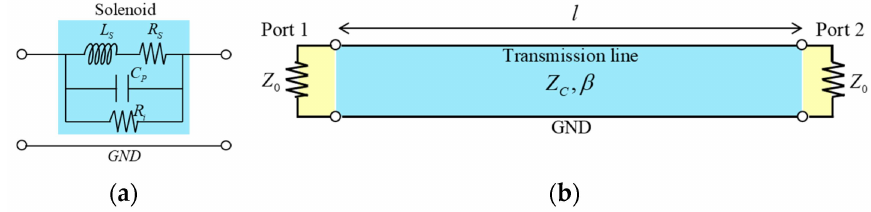
Figure 1. ( a ) Lumped element model for a solenoid in low frequency range (under the second resonance frequency); ( b ) Finite length transmission line model emphasizing distribution